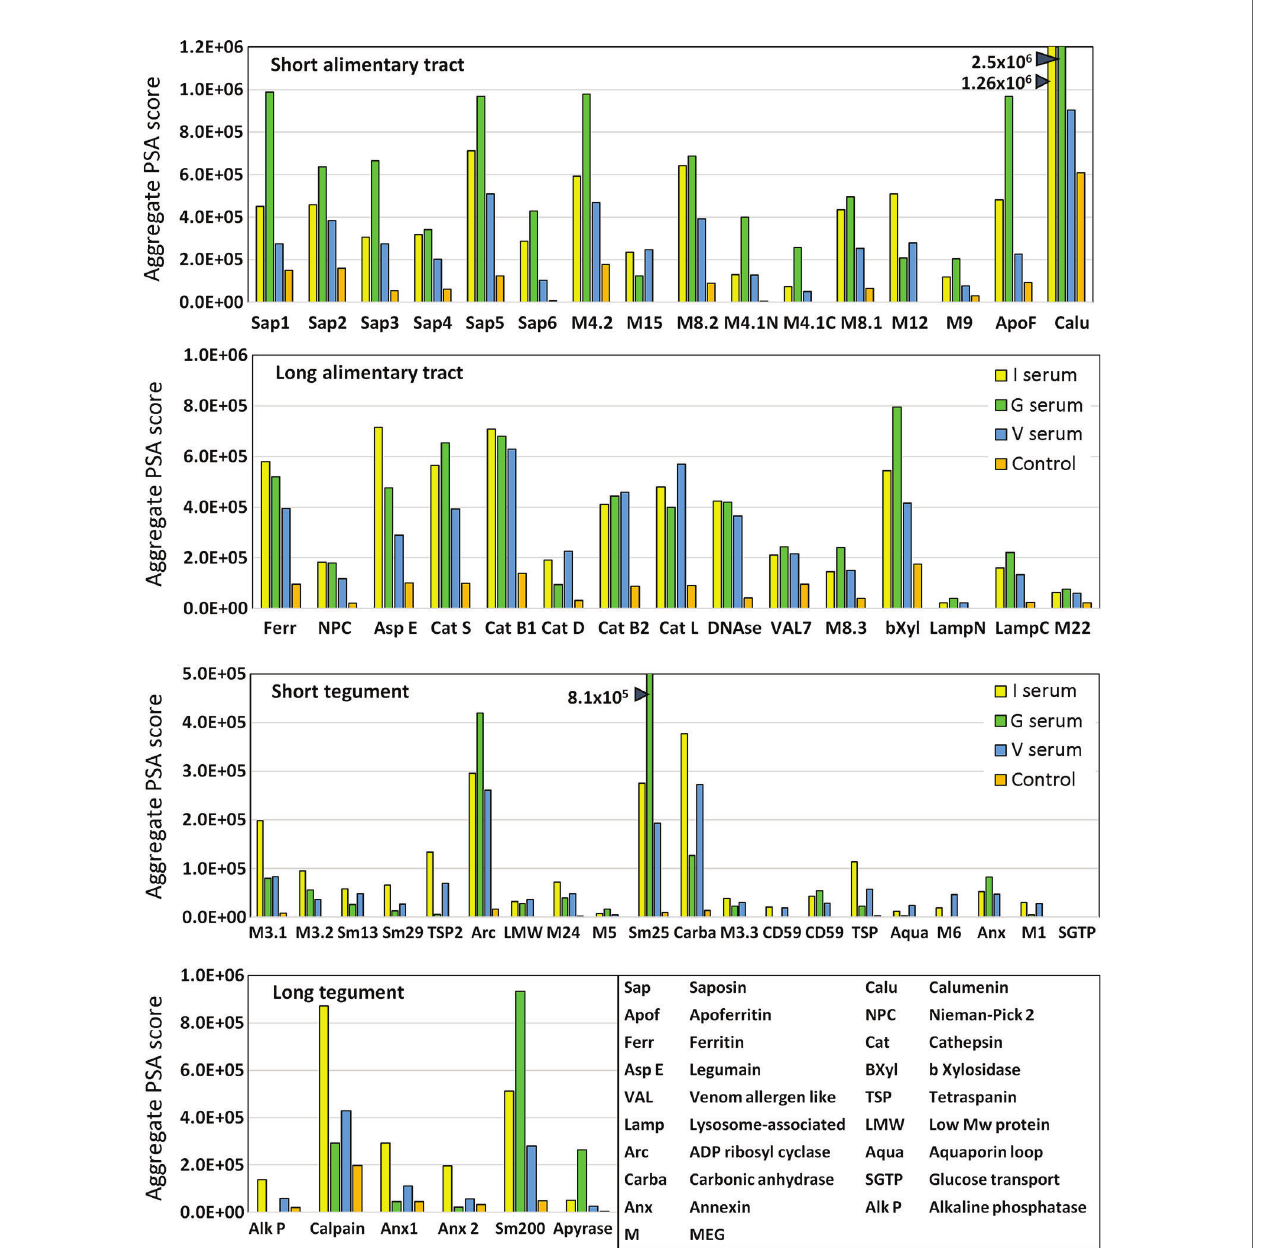
FIGURE 4 | Bar chart summarizing the reactivity of all proteins on the four arrays, based on the data in Supplementary Table 2 . The y axis is cumulative Agilent peptide score above zero, ignoring protein length for each protein. The means of three I, three V, and two G results are plotted plus one control serum. Note the much weaker response of tegument compared to alimentary tract proteins (y axis